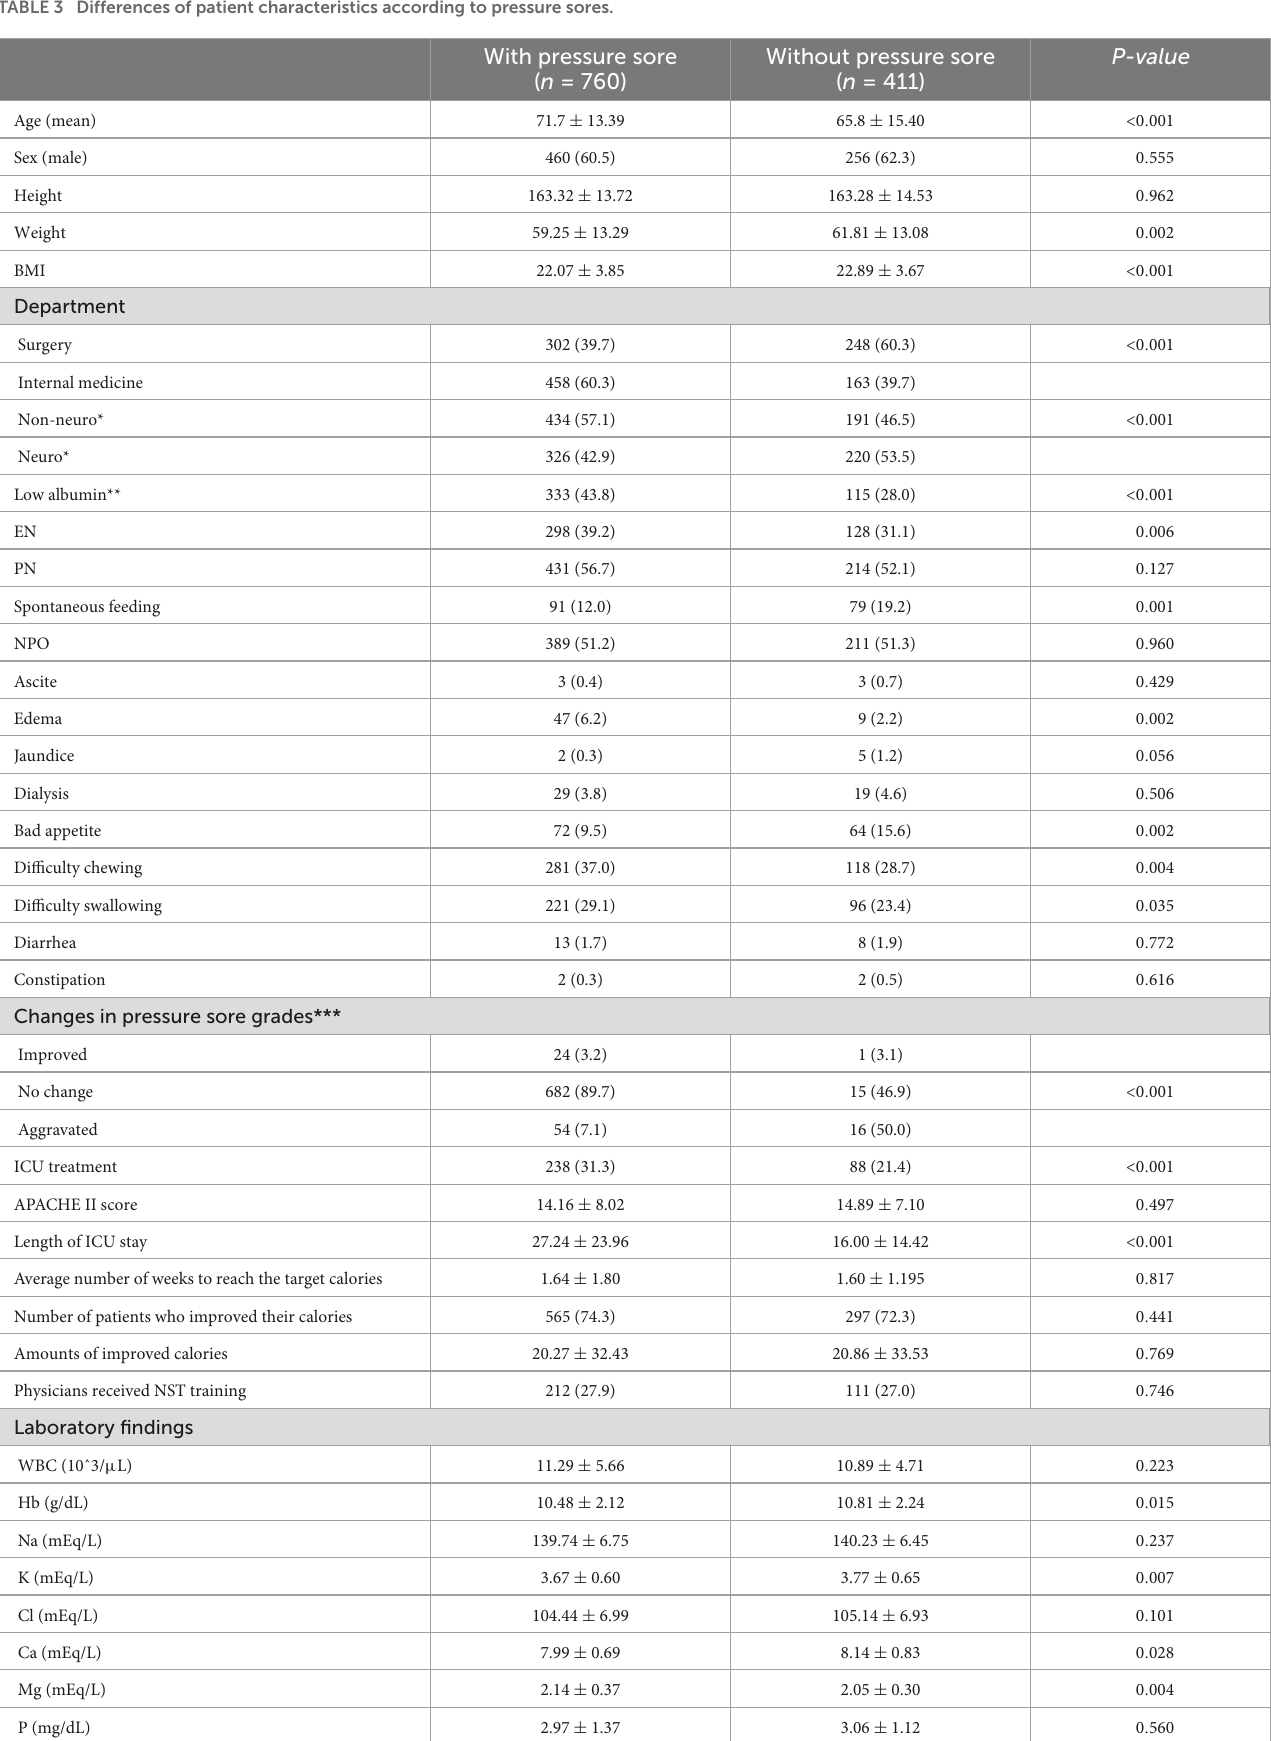
TABLE 3 Differences of patient characteristics according to pressure